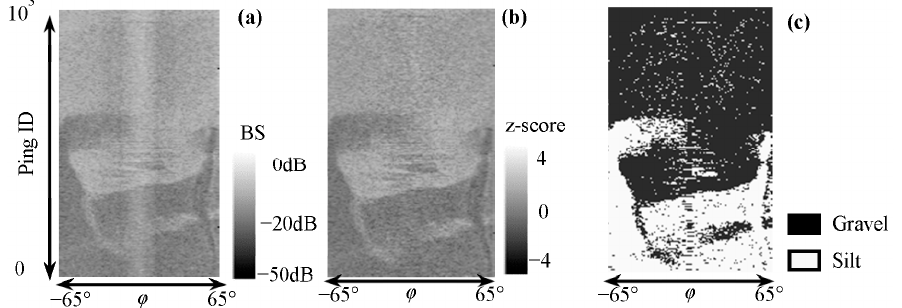
Figure 4. Seabed classification on MBES waterfall image using the z -score and k -mean++ algorithm. ( a ) Raw MBES waterfall image; ( b ) normalized z -score image; and ( c ) classification result with k = 2. φ is the incident angle of each beam.